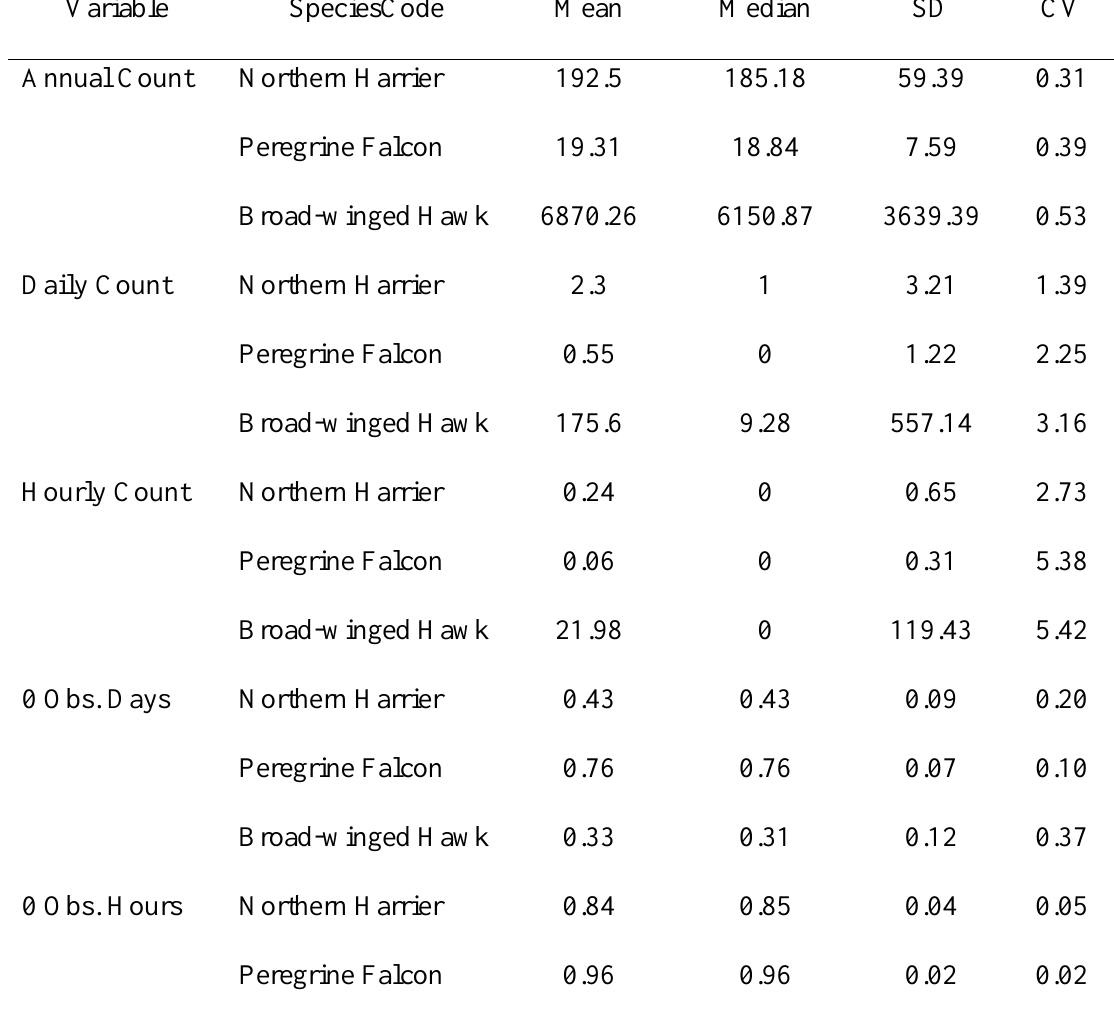
Table A2.2. Mean across 100 simulated datasets of the mean, median, standard deviation (SD) and coefficient of variation (CV) for annual, daily and hourly counts, proportion of 0-observation days and hours, and number of days between first and last detection for three raptor